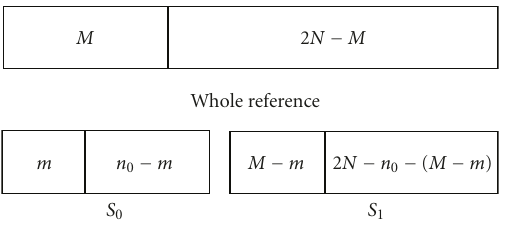
Figure 2: Position of noise samples in nonhomogeneous environ-